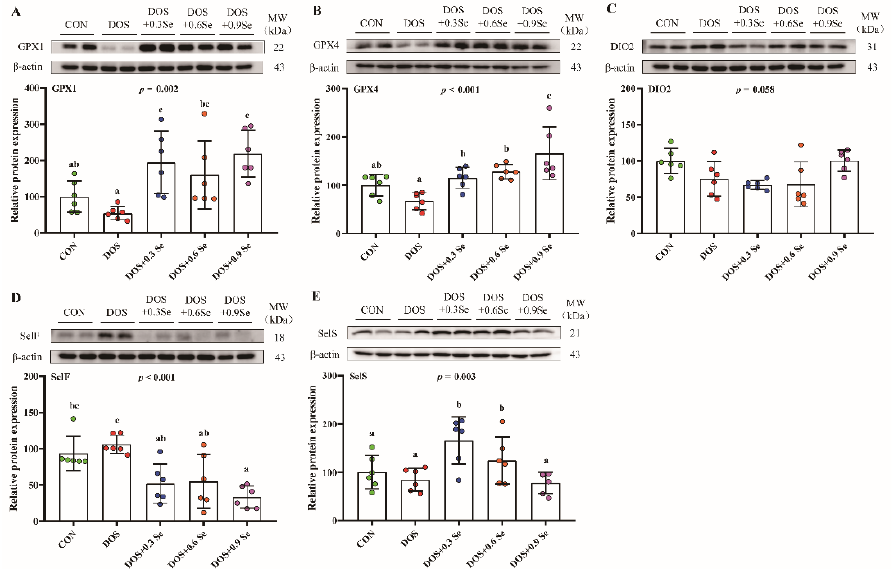
Figure 5. Effects of dietary oxidative stress and OH-SeMet supplementation on the expression of selenoproteins in liver of growing-finishing pigs. ( A ) Relative protein abundance of GPX1; ( B ) Relative protein abundance of GPX4; ( C ) Relative protein abundance of DIO2; ( D ) Relative protein abundance of SelF; ( E ) Relative protein abundance of SelS. The results were expressed as mean ± SD ( n = 6), different letters indicate ANOVA p value less than 0.05 which represent there is a significant difference between